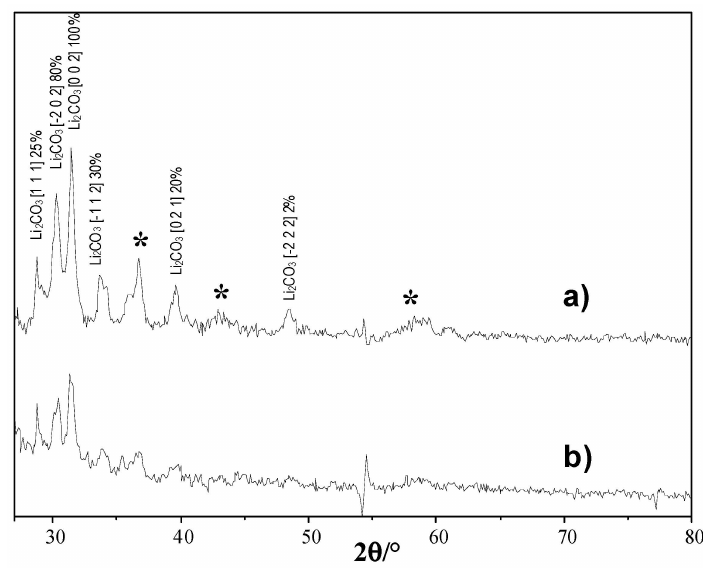
Figure 8. X-ray diffraction lines of ( a ) GDE-H-M_hydro and ( b ) GDE-H-M_hydro_1.0%Ag obtained by subtraction between the GDEs after five cycles and before cycling. The * label indicates the presence of MnO 2